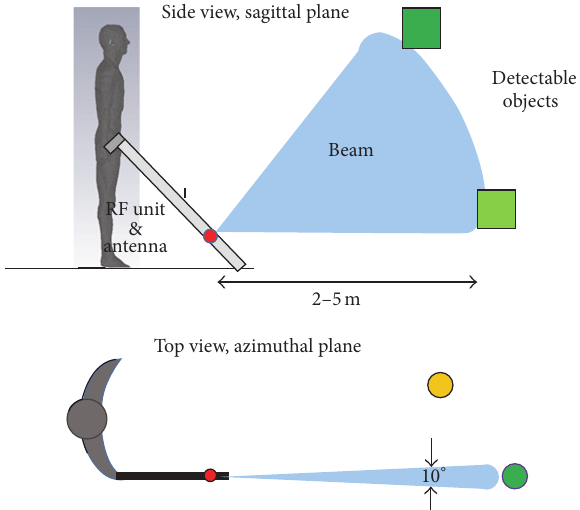
Figure 2: Scheme of the considered